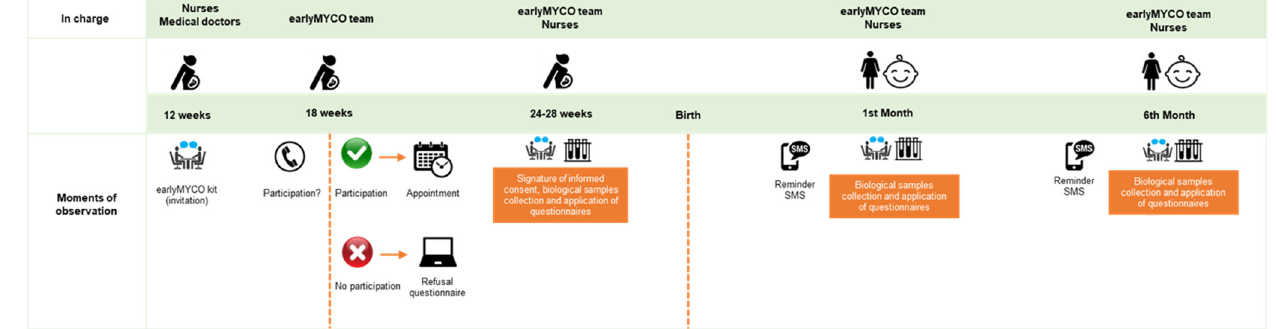
Figure 2. Design of earlyMYCO mother–child pilot cohort study.